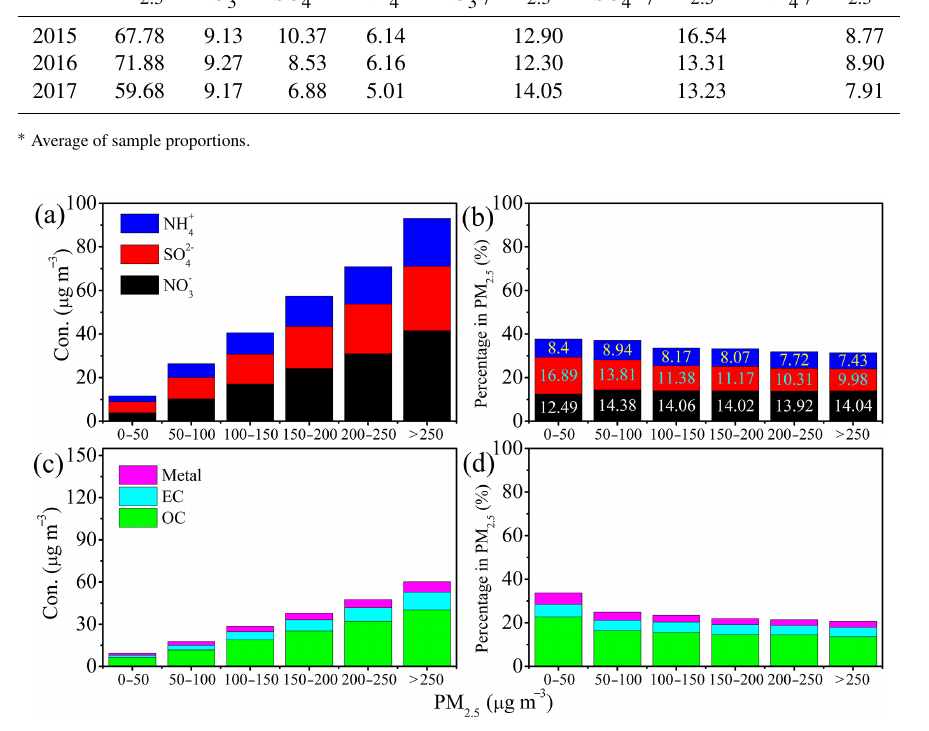
Figure 2. Variation characteristics of the NSA (nitrate, sulfate and ammonium) and other chemical compositions with different concentrations of PM 2 . 5 . (a) NSA mass concentration. (b) Percentage of NSA in PM 2 . 5 . (c) Chemical compositions of organic carbon (OC), elemental carbon (EC) and metal elements. (d) Percentage of OC, EC and metal elements in PM 2 . 5